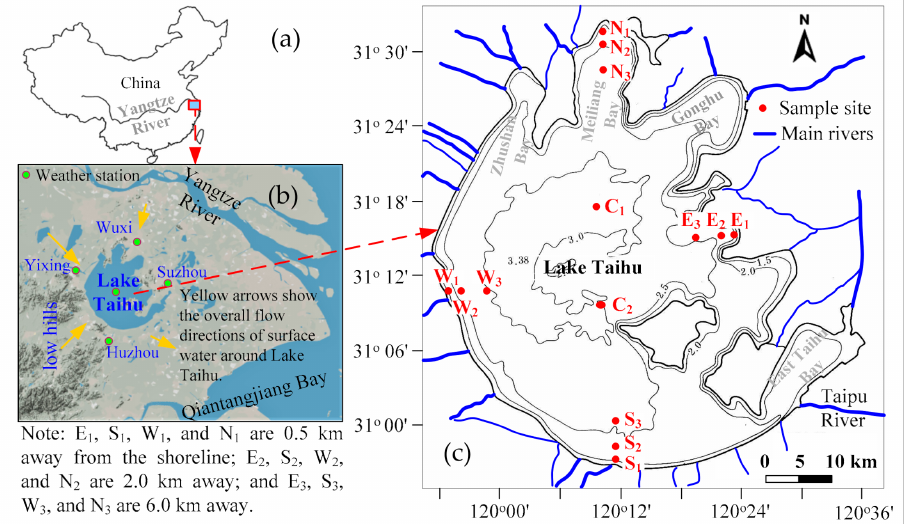
Figure 1. ( a ) Location of Lake Taihu in China; ( b ) schematic topography and overall surface water flow directions (yellow arrows) around the lake and weather stations; ( c ) main rivers (blue lines) around the lake and sampling sites (red dots) of the hyporheic